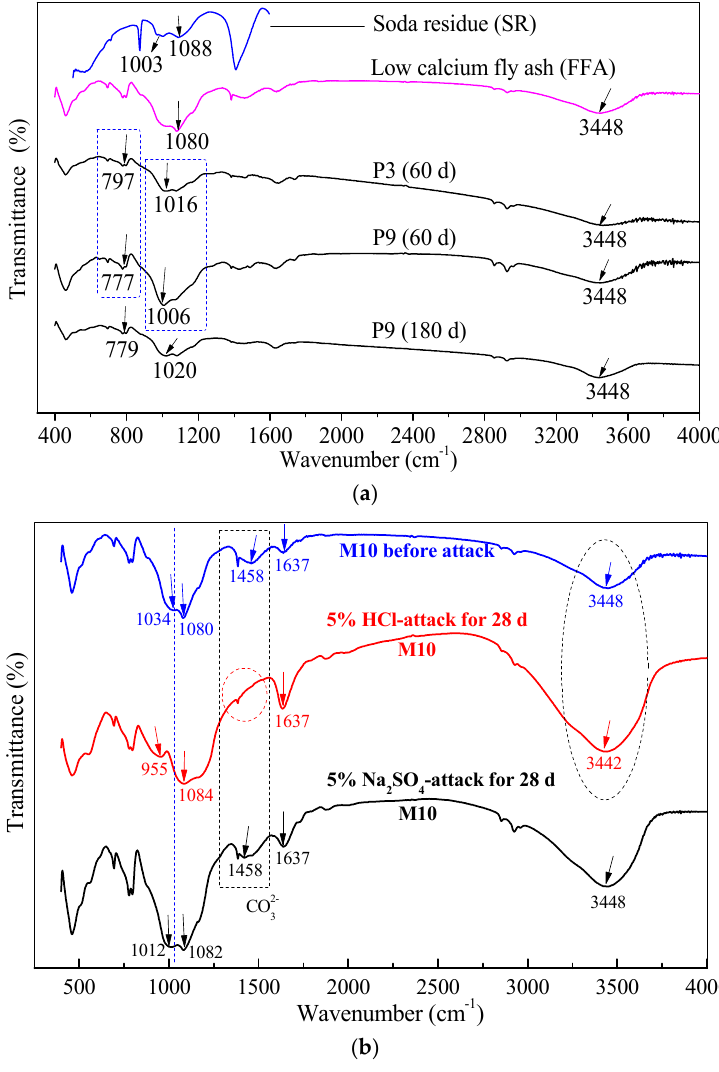
Figure 8. ( a ) FTIR spectra of low-calcium fly ash (FFA), soda residue (SR), paste P3 and paste P9 cured at room temperature for 60 and 180 d; ( b ) FTIR spectra of SR–FFA–GEO mortar M10 cured for 360 d before and after 5% HCl and 5% Na 2 SO 4 attack.